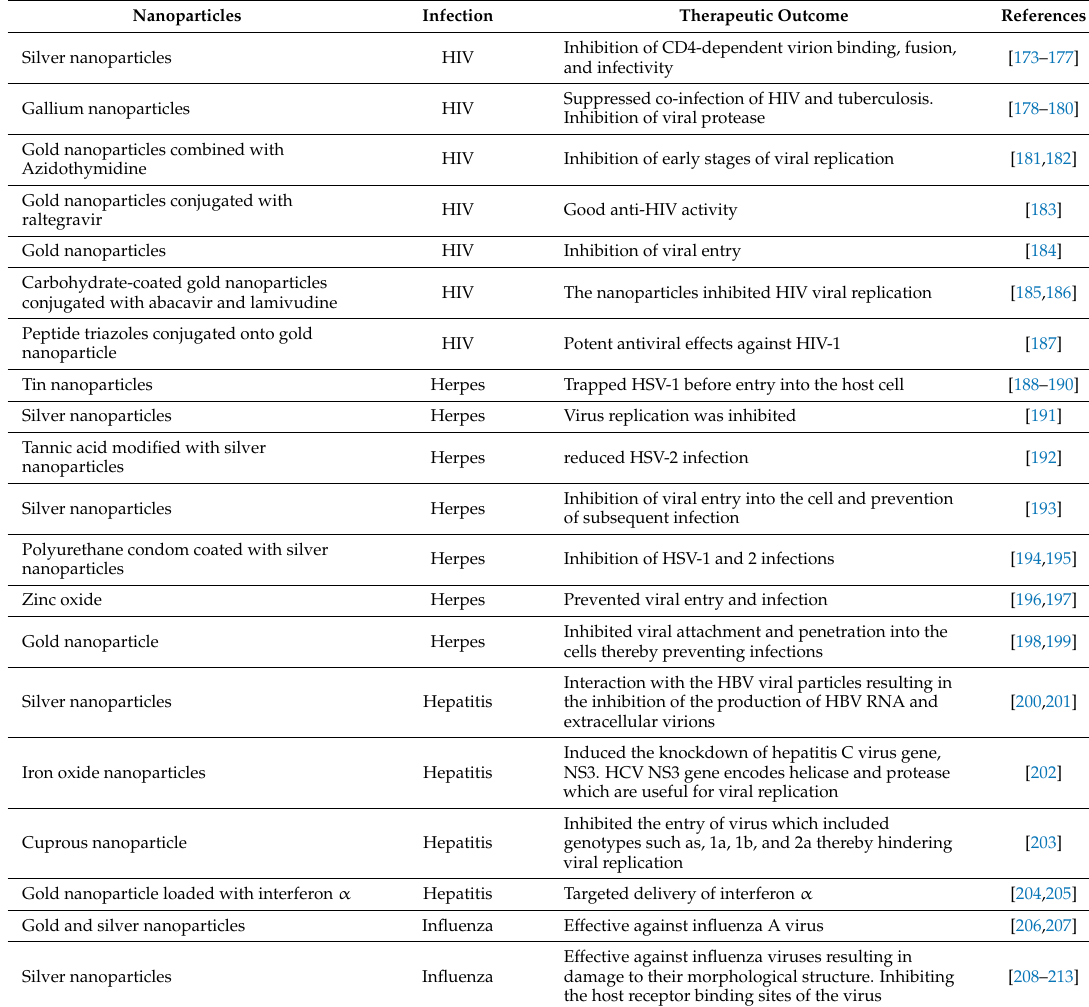
Table 5. Metal-based nanoparticles with antiviral